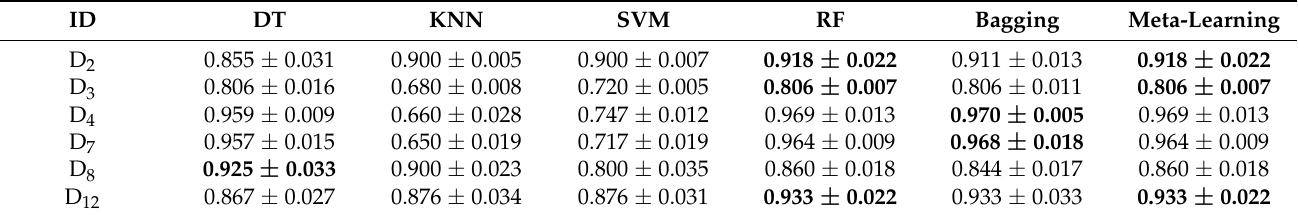
Table 6. Accuracy comparison between meta-learning and traditional ML algorithms in